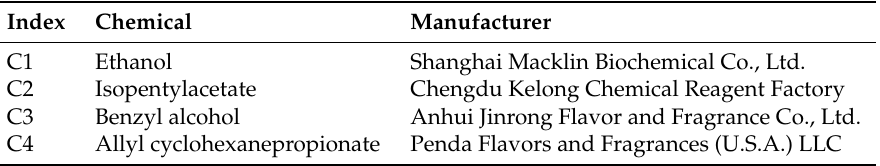
Table 2. Fragrance sources used in the experiment.